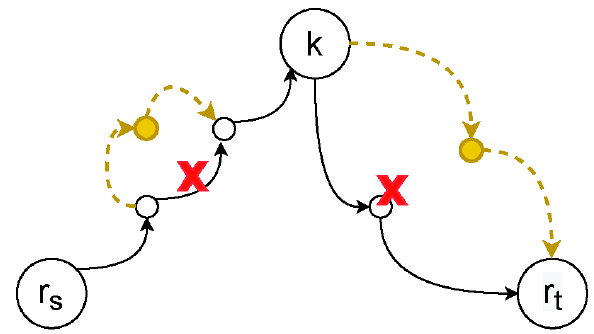
Figure 6. IGP-based rerouting mechanism in SRC.